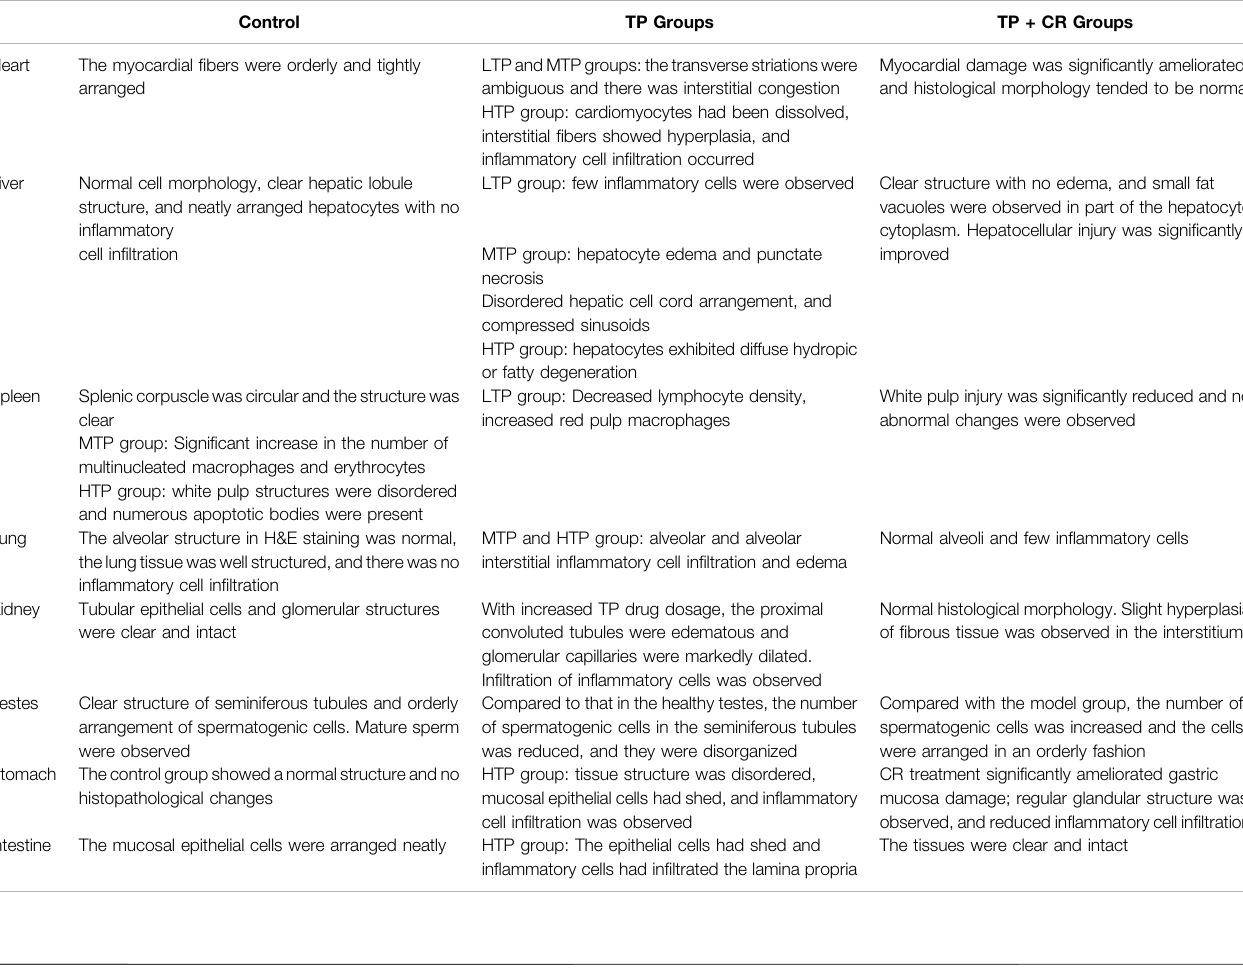
TABLE 4 | Morphological and pathological manifestations of mice in each group.